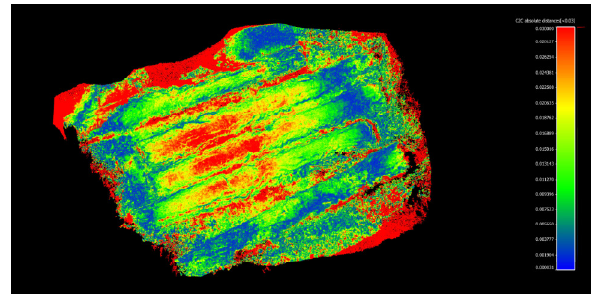
Figure 12. Point clouds of GoPro video photogrammetric survey. Compared distance with points cloud obtained with GoPro